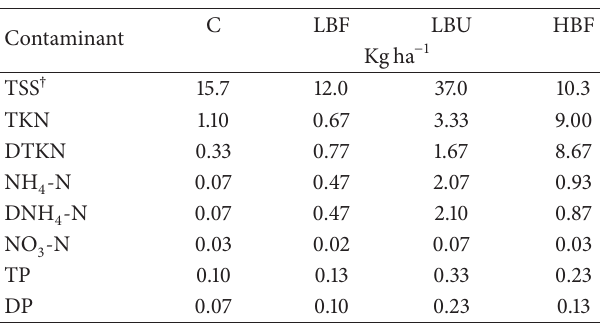
Table 4: Untransformed treatment means for all analyzed biosolids nutrients in runoff from Experiment 1 simulated rainfall plots. Note: values have been extrapolated to kg ha − 1 basis.